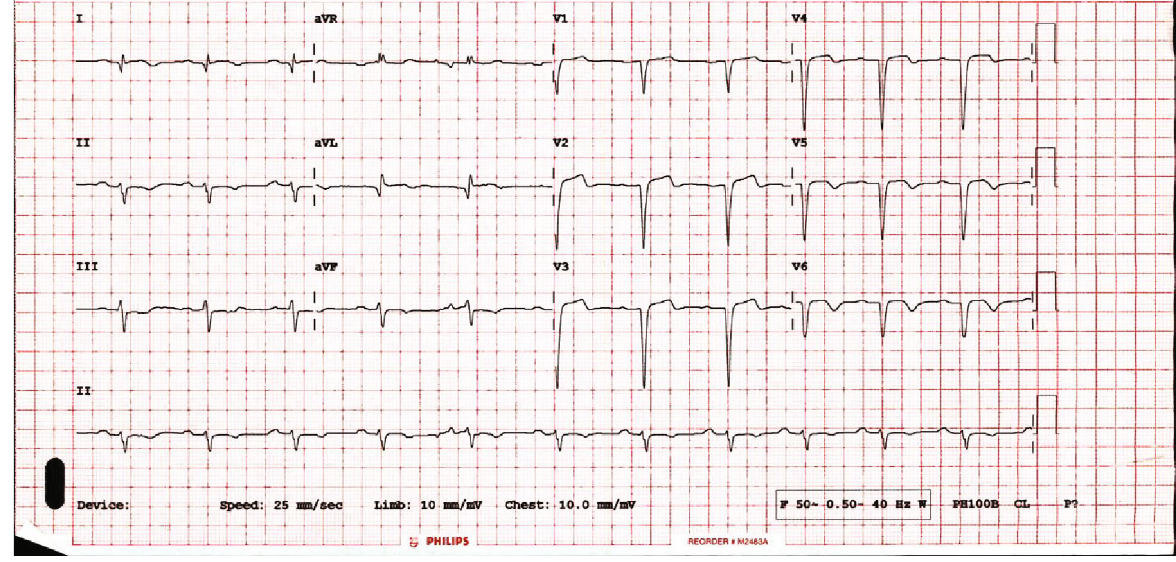
Figure 1: ECG at presentation.